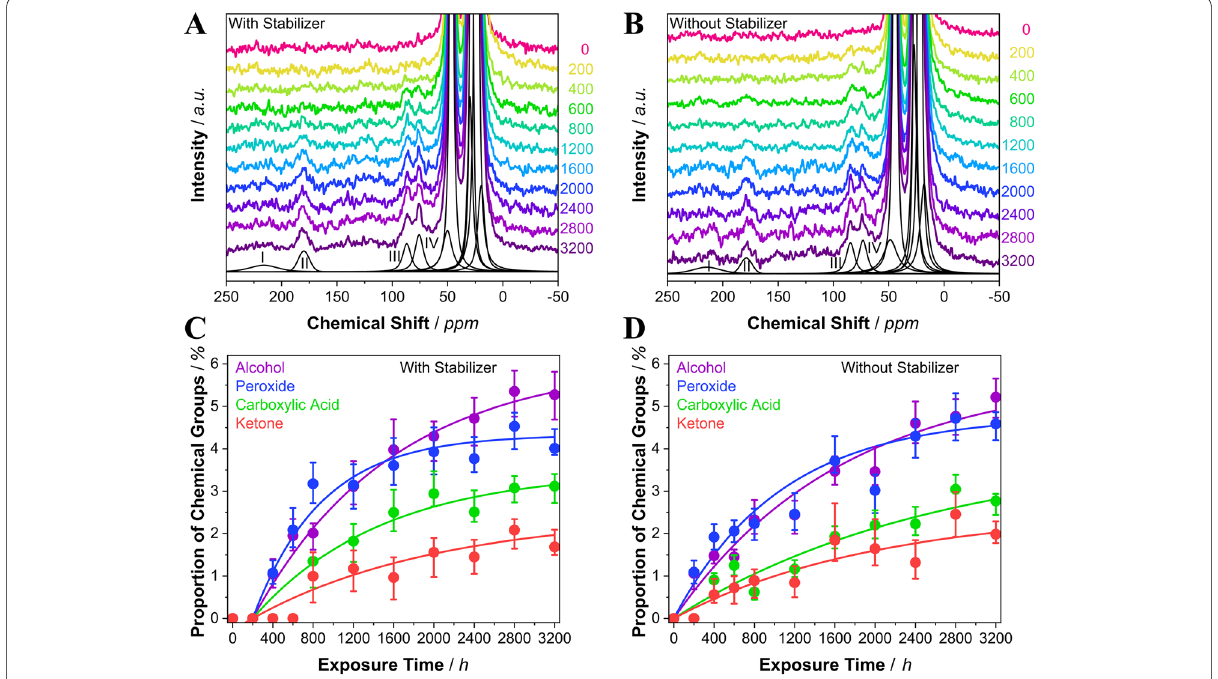
Fig. 4. 13 C CP MAS NMR spectra of A PP with stabilizer and B without stabilizer for different weathering times. Upon irradiation, the generation of new signals assigned as signals I (ketone), II (carboxylic acid), III (peroxide) and IV (alcohol) is observed [56, 57]. No refinement of vinylidenes was performed between 100–150 ppm, since the resonances of the decomposition products of Irgafos ® 168 superimpose with the vinylidene resonances. The spectra are normalized to the intensity of the methyl sidechain carbon signal (at approx. 24 ppm). Individual spectra are shifted vertically for better comparability. Exemplarily, the individual fits for the peaks in the spectrum of the 3200 h weathered particles are shown as black lines; Derived proportions (SI Eq. 2 - Eq. 6) of alcohols, peroxides, carboxylic acids and ketones, as functions of the exposure time, for PP particles C with and D without stabilizer. Trend curves with exponential build-up and an induction period (PP with stabilizer) are included as guide for the